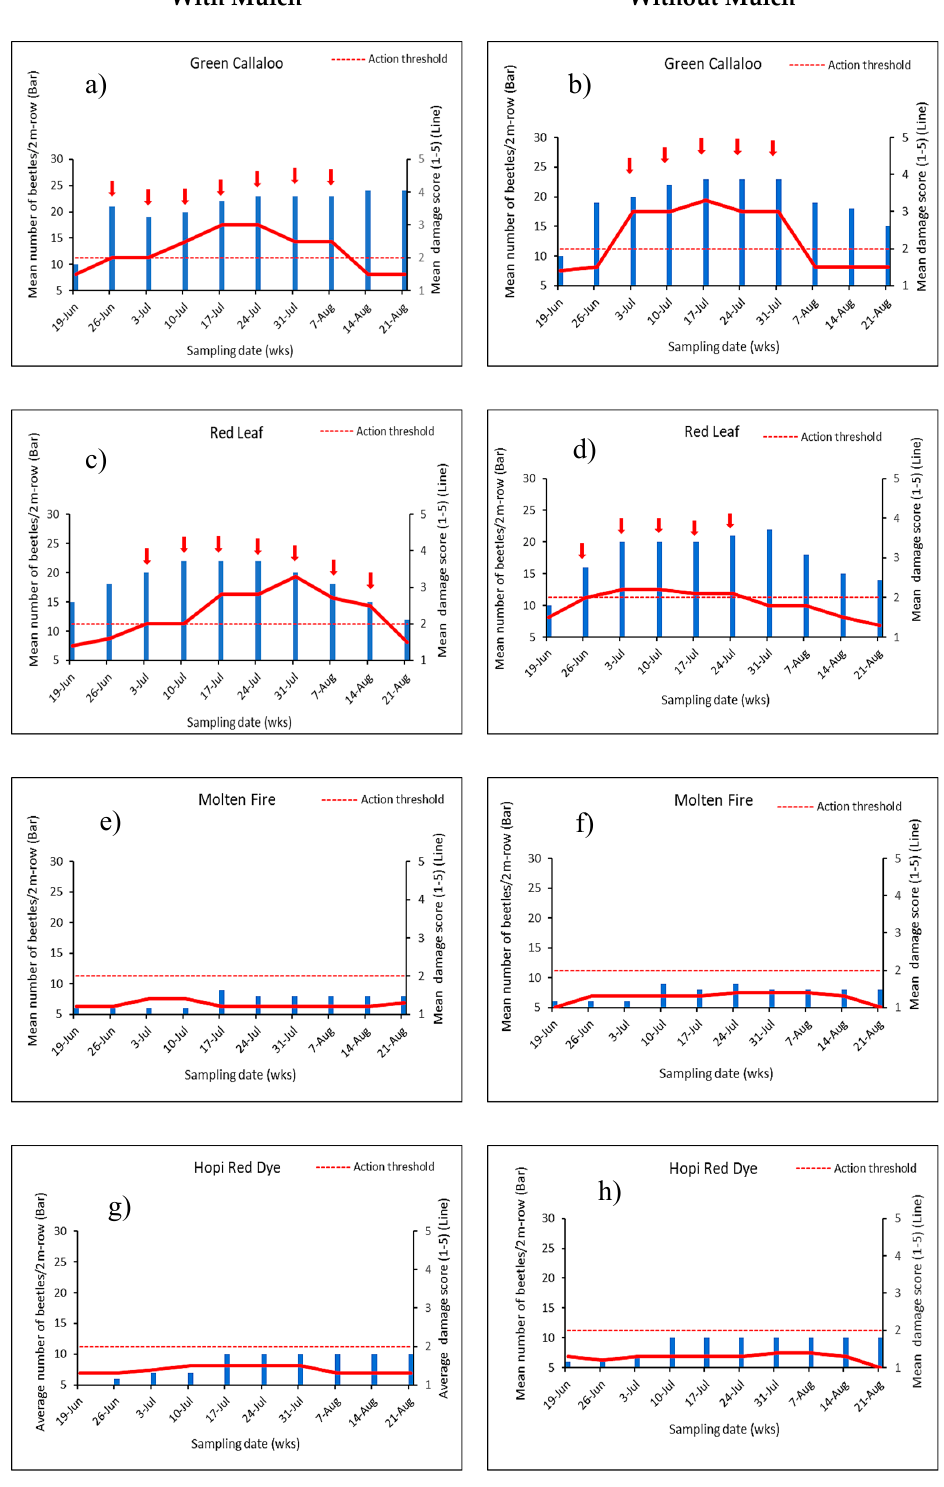
Figure 5. Graphs showing the weekly mean beetle population and the corresponding damage (i.e., scores = 1: 0–20%, 2: > 20–40 %, 3: > 40–60 %, 4: > 60–80 % and 5: > 80–100% leaf damage) and the action threshold for each amaranth variety in 2018. Arrows [in a—d] represent presumptive insecticide treatment times ( ≥ action threshold score of 2).